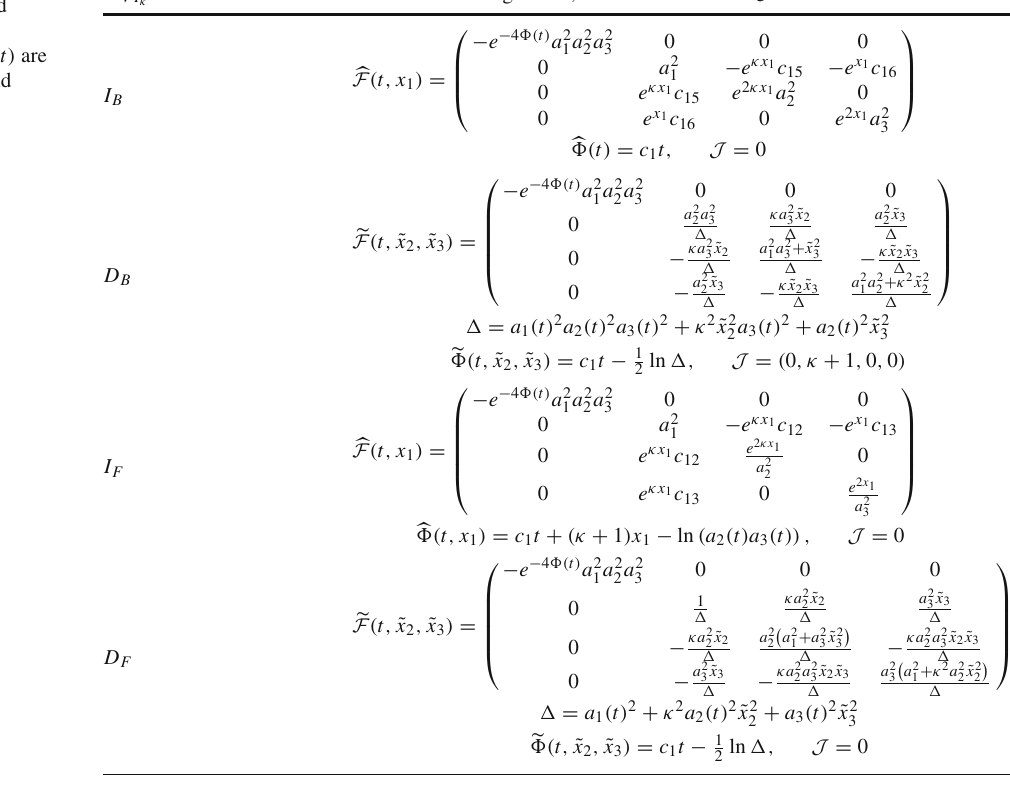
Poisson–Lie identities and dualities of Bianchi V I − 1 cosmology. Functions a i ( t ) are given by (47) and (cid:14)( t ) = c 1 t